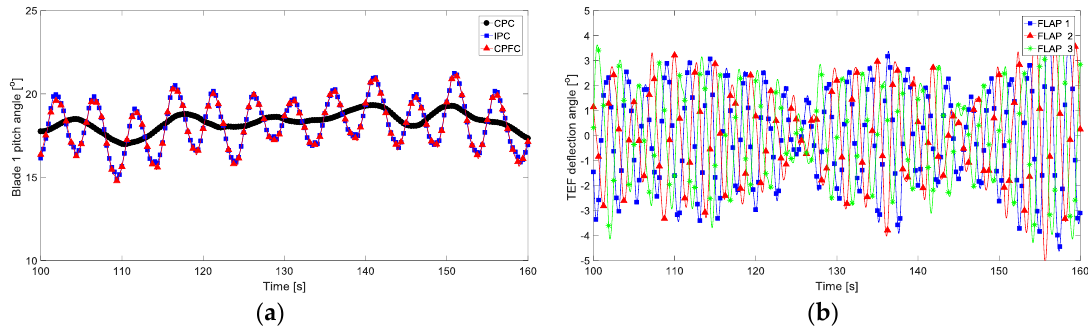
Figure 10. The power generation of a wind turbine. 4.3.6. The Blade 1 Pitch Angles and TEFs Deflection Angles The blade 1 pitch angles and TEFs deflection angles by CPC, IPC, CPFC are shown in Figure 11.